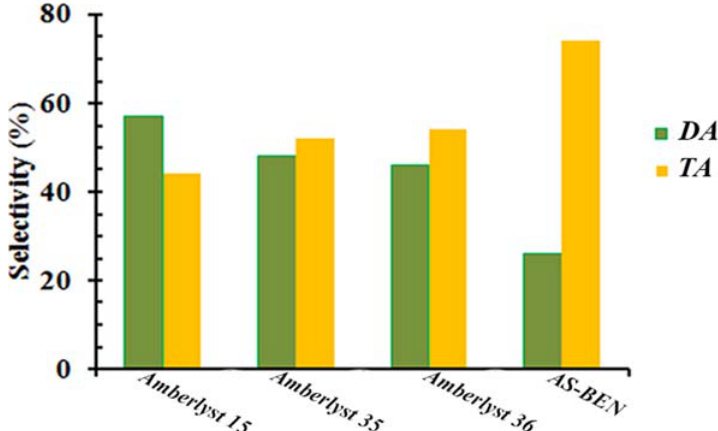
Figure 6. Catalytic behavior of different catalysts at reaction conditions: AA/Gly = 7, 3 h, 100 °C.